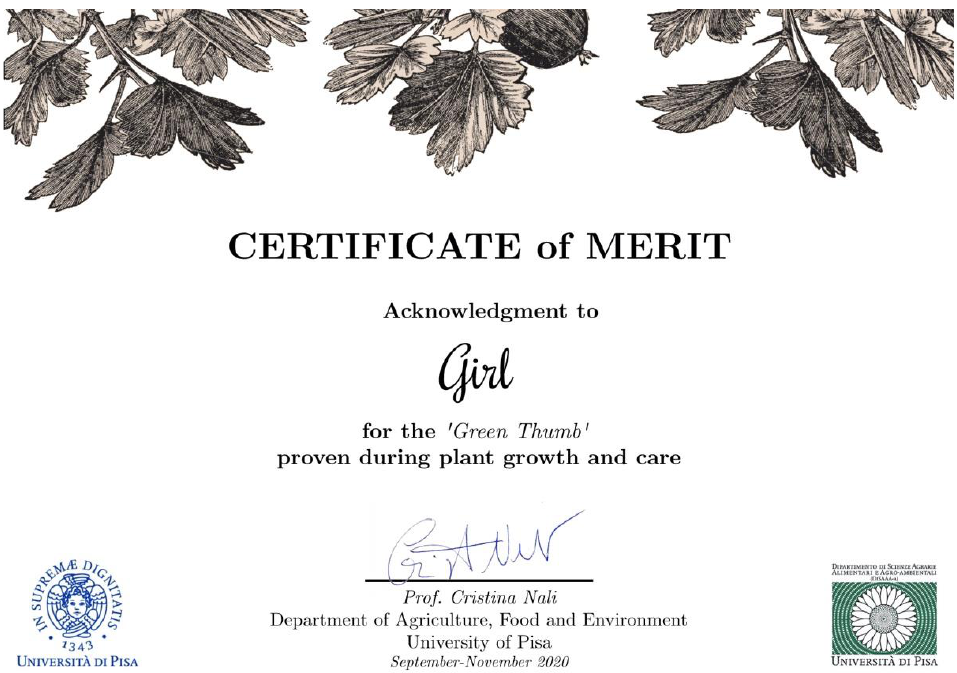
Figure 2. A ‘green thumb’ certification given to each patient in the experimental group at the end of the HCT.